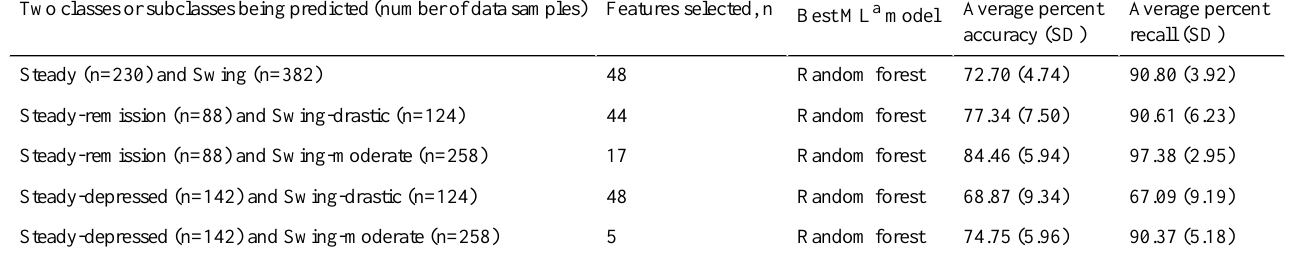
Table 4. Classification result using selected features of sleep data.